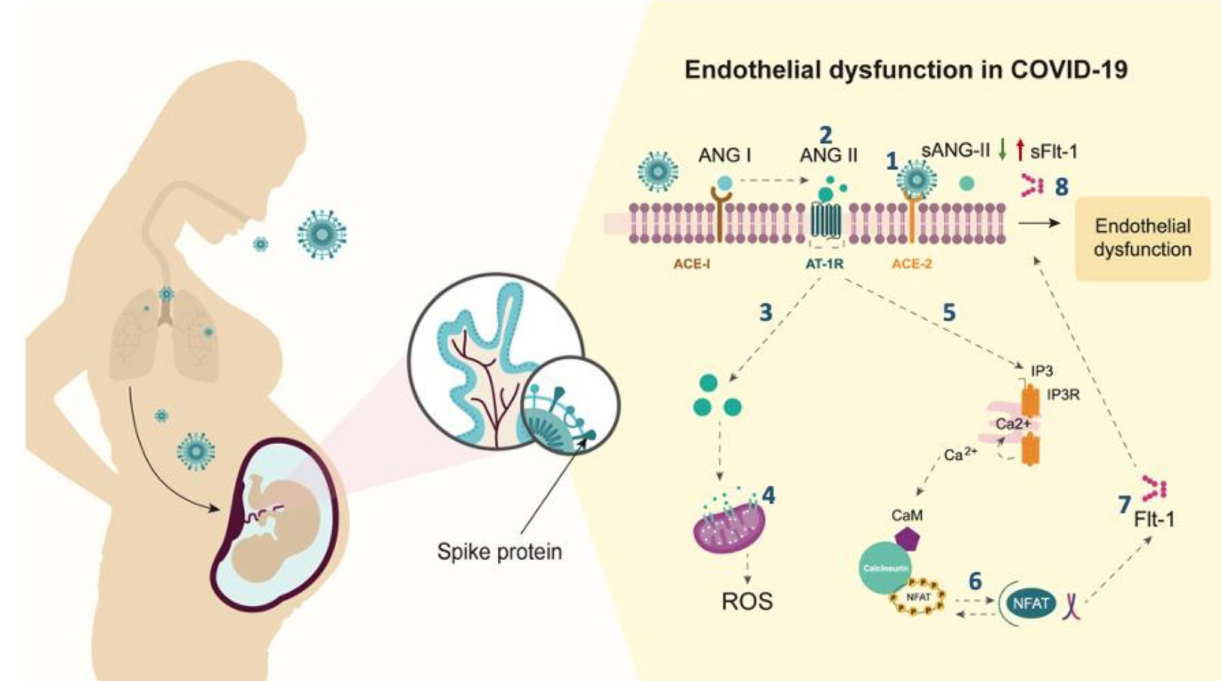
Figure 3. Hypothetical molecular mechanisms contributing to the pathogenesis of severe COVID-19 in pregnant women. Spike protein of SARS-CoV-2 virus binds to trophoblastic cells expressing ACE-2, (1) blocking the conversion of ANG-II into ANG 1-7 [3]. (2) Accumulation of ANG-II on the cell surface enhances its binding to the AT-1 receptor (AT-1R), promoting downstream signaling, followed by rapid endocytosis of the ANG-II/AT-1R complex [24]. (3) By avoiding the endosome/lysosome degradation, the excess of ANG-II is accumulated in endothelial cells [25]. (4) ANG-II binds to mitochondrial AT-1R [26], inducing cellular senescence with positive regulation of reactive oxygen species (ROS) [27]. (5) Over-activation of AT-1R on the cell membrane leads to increased PKC and calcineurin activity [25]. (6) Transcription factors NF-kB and NFAT are activated and translocated to the nucleus, leading to an increase in gene expression and release of Flt-1 [25]. (7) Flt-1 alternative splicing generates sFlt-1 isoform [25]. (8) The excess of sFlt-1 protein is released into the circulation causing endothelial